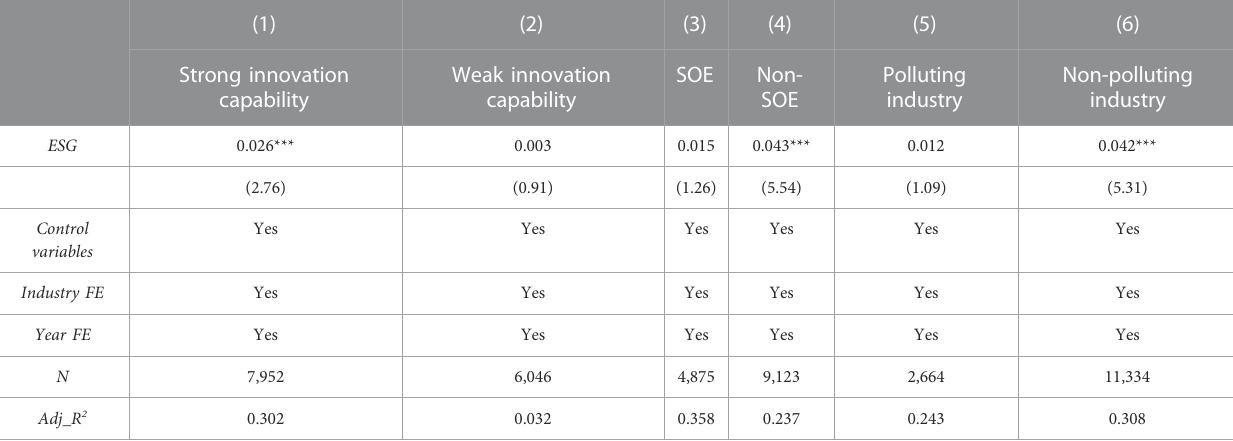
TABLE 8 Heterogeneity analysis results: Based on fi rm